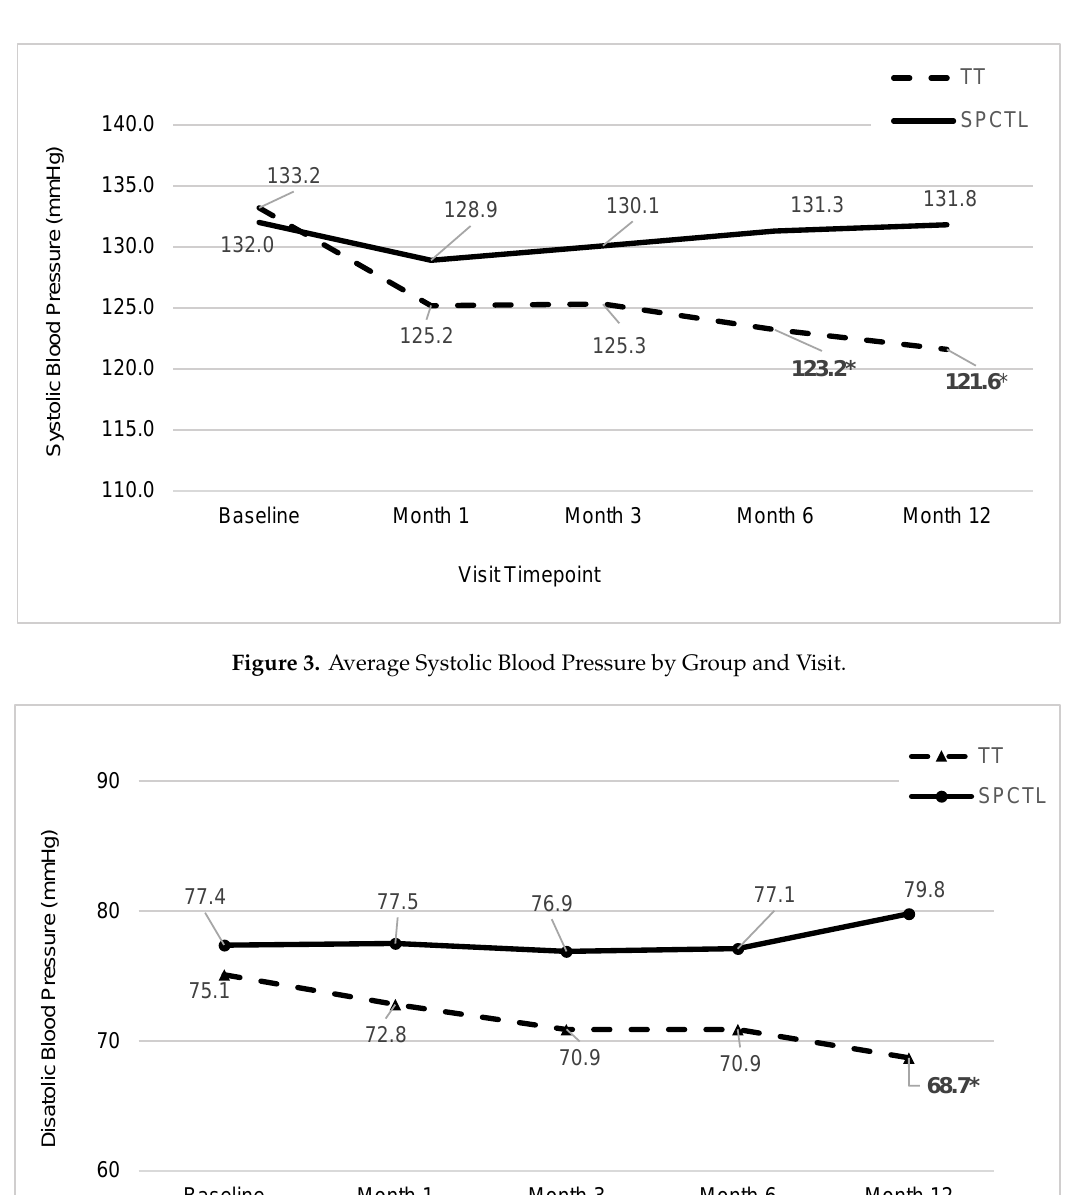
Figure 4. Average Diastolic Blood Pressure by Group and Visit.